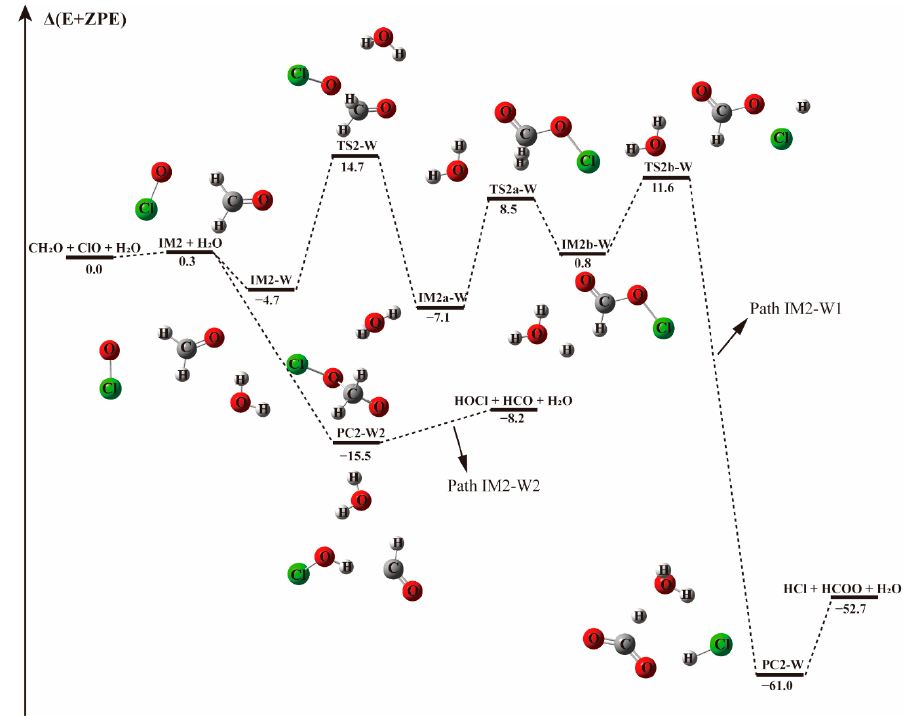
Figure 3. The energy profile of the CH 2 O + ClO water-fee reaction occurring through IM2 + H 2 O pathway. Energies (in kcal mol − 1 ) are calculated at the CCSD(T)/aug-cc-pVTZ//B3LYP-D3/aug-cc- pVTZ